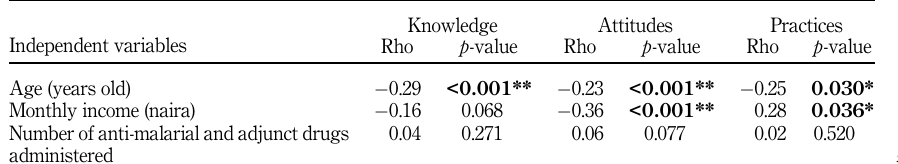
Table III. Correlations between